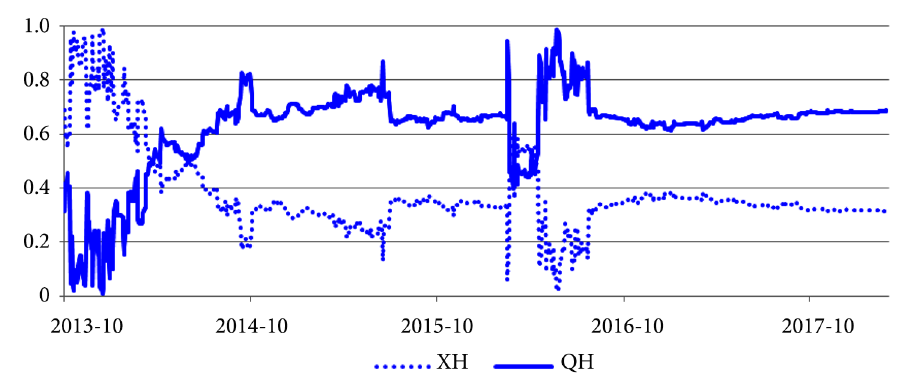
Figure 2. Contribution of price discovery in iron ore futures market (QH) and spot market (XH)